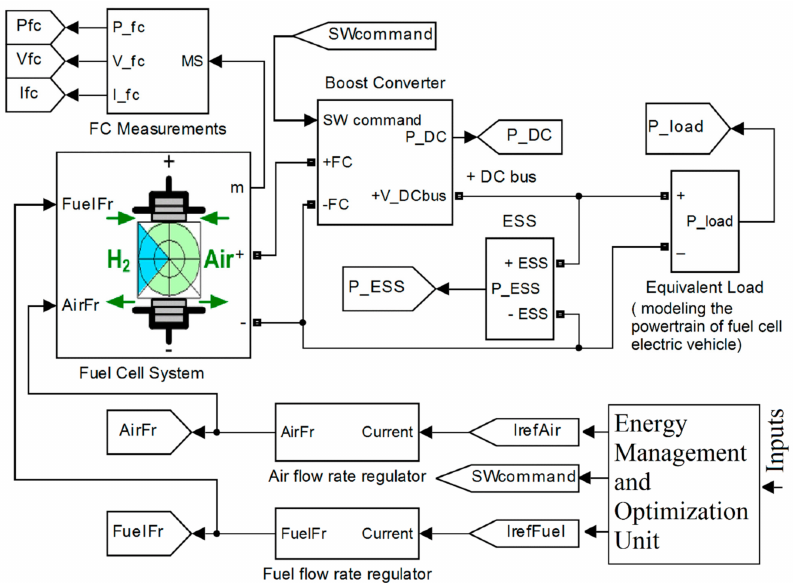
Figure 1. Fuel cell hybrid power system (FCHPS) diagram using an equivalent DC load for the powertrain of fuel cell electric vehicle.